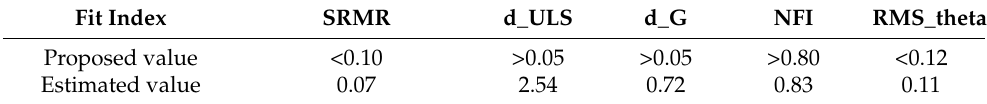
Table 7. Fit indices of the structural